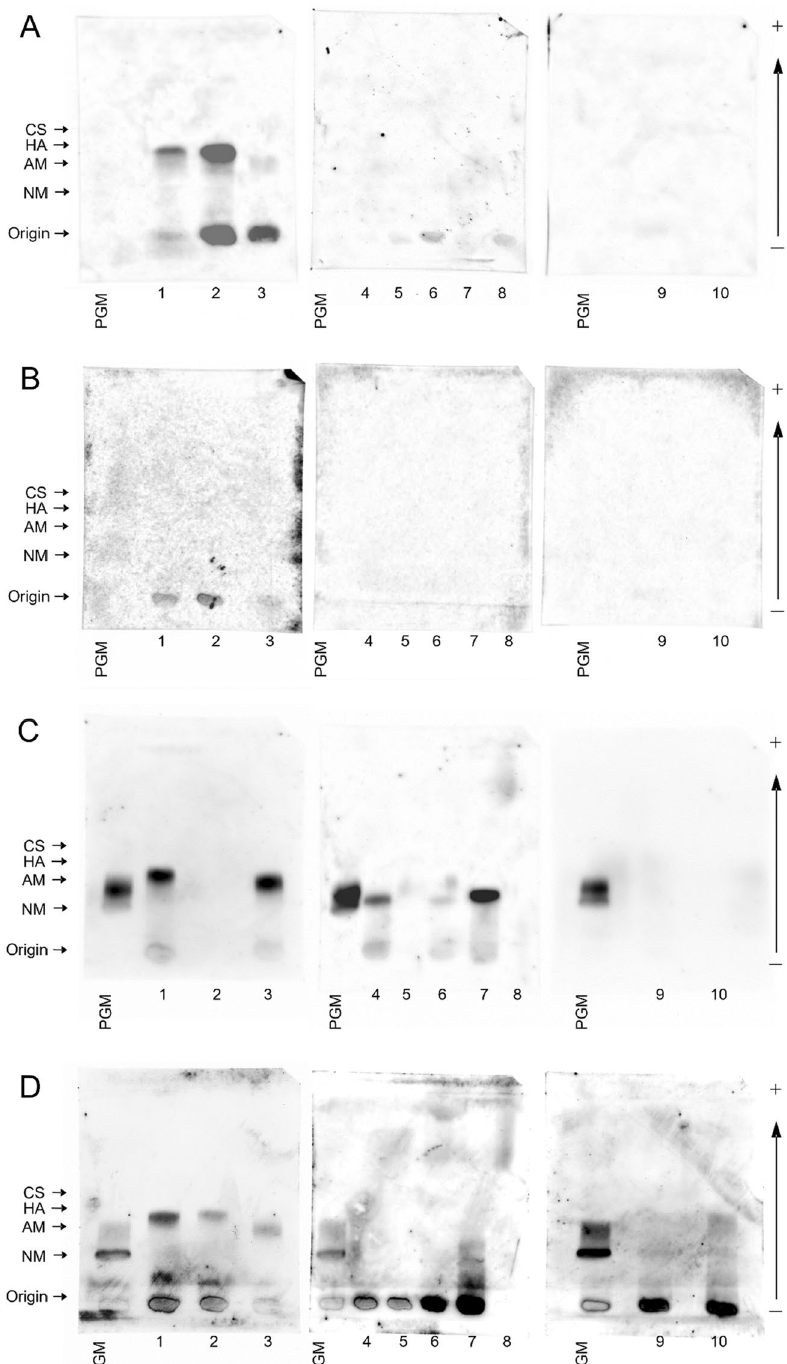
Figure 1. Lectin blotting of the SMME membranes separating salivary gland homogenates. ( A ) MAL-II; ( B ) SSA; ( C ) BC2LCN; ( D ) AAL. Sample numbers 1–3: MEC and 4–10: NSGs. Sample properties are summarised in Table 3. Partially purified porcine gastric mucin (PGM) was used as a reference mixture of chondroitin sulphate (CS), hyaluronic acid (HA), acidic mucin (AM) and neutral mucin (NM). The migrating positions of these components of PGM were estimated from a previous report 19 . The original, unprocessed versions of full- length lectin blotting images are included in the supplemental (Supplemental Fig.